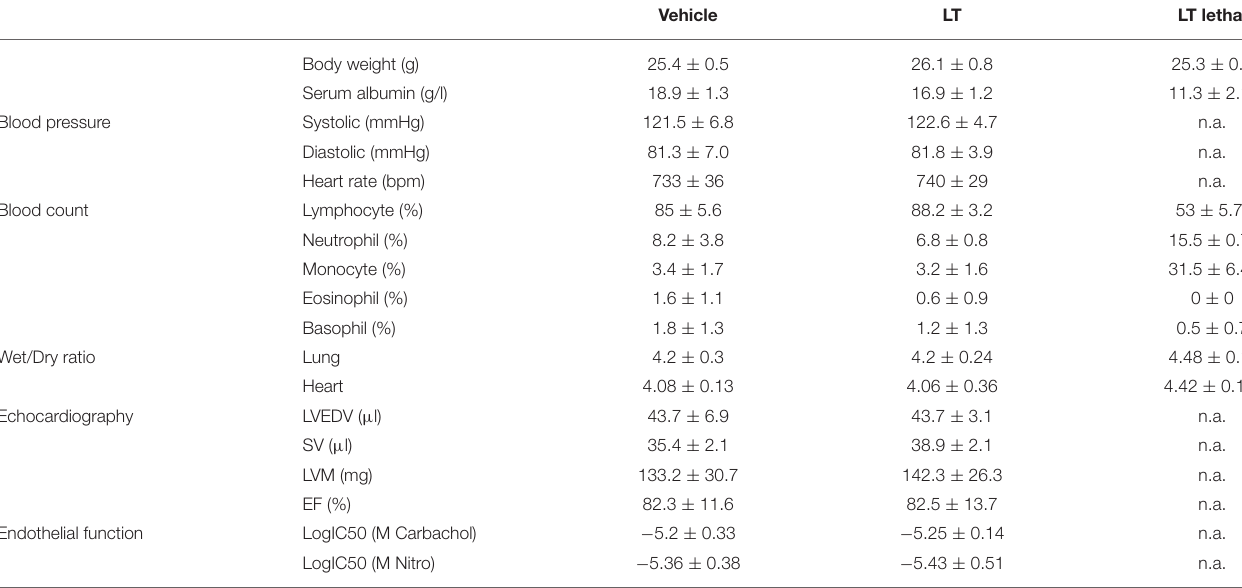
TABLE 1 | Assessment of Clostridium sordellii lethal toxin (LT)